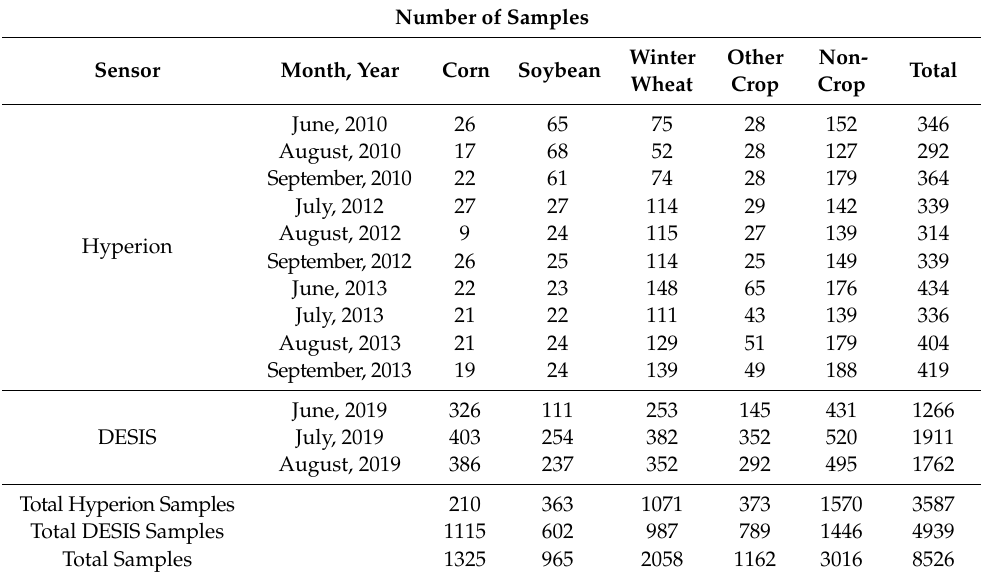
Table 3. Total samples. Hyperion and DESIS total samples. Hyperion samples were then split into training (37.5%), testing (37.5%), and validation (25%) subsets. Similarly, DESIS samples were split into training (33.3%), testing (33.3%), and validation (33.3%) subsets.